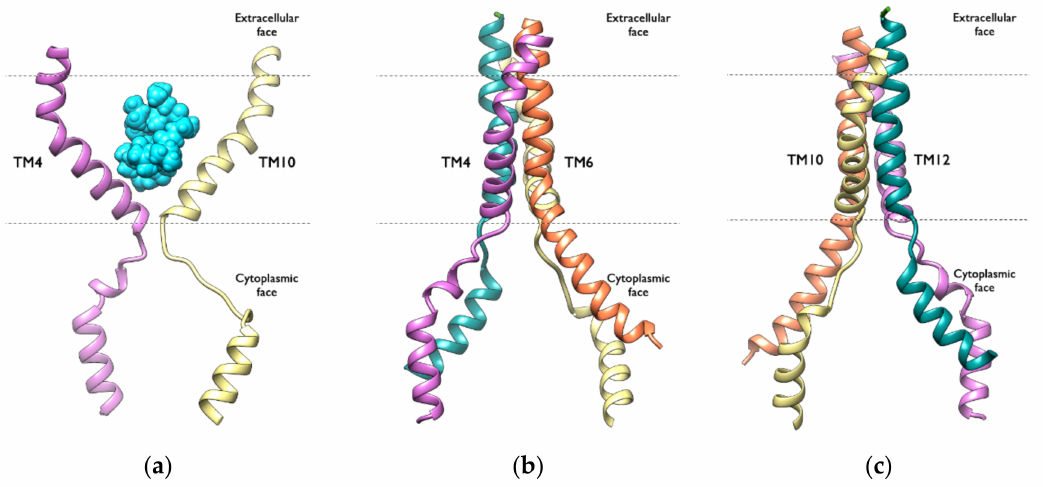
Figure 11. Ribbon representation of the TM segments which are important for the P-gp activity: ( a ) TM4 (pink) and TM10 (yellow) adopting a kinked conformation, with CSA located in the centre of the occluded cavity; ( b ) the TM4 (pink) and TM6 (orange) portal; ( c ) the TM10 (yellow) and TM12 (green)